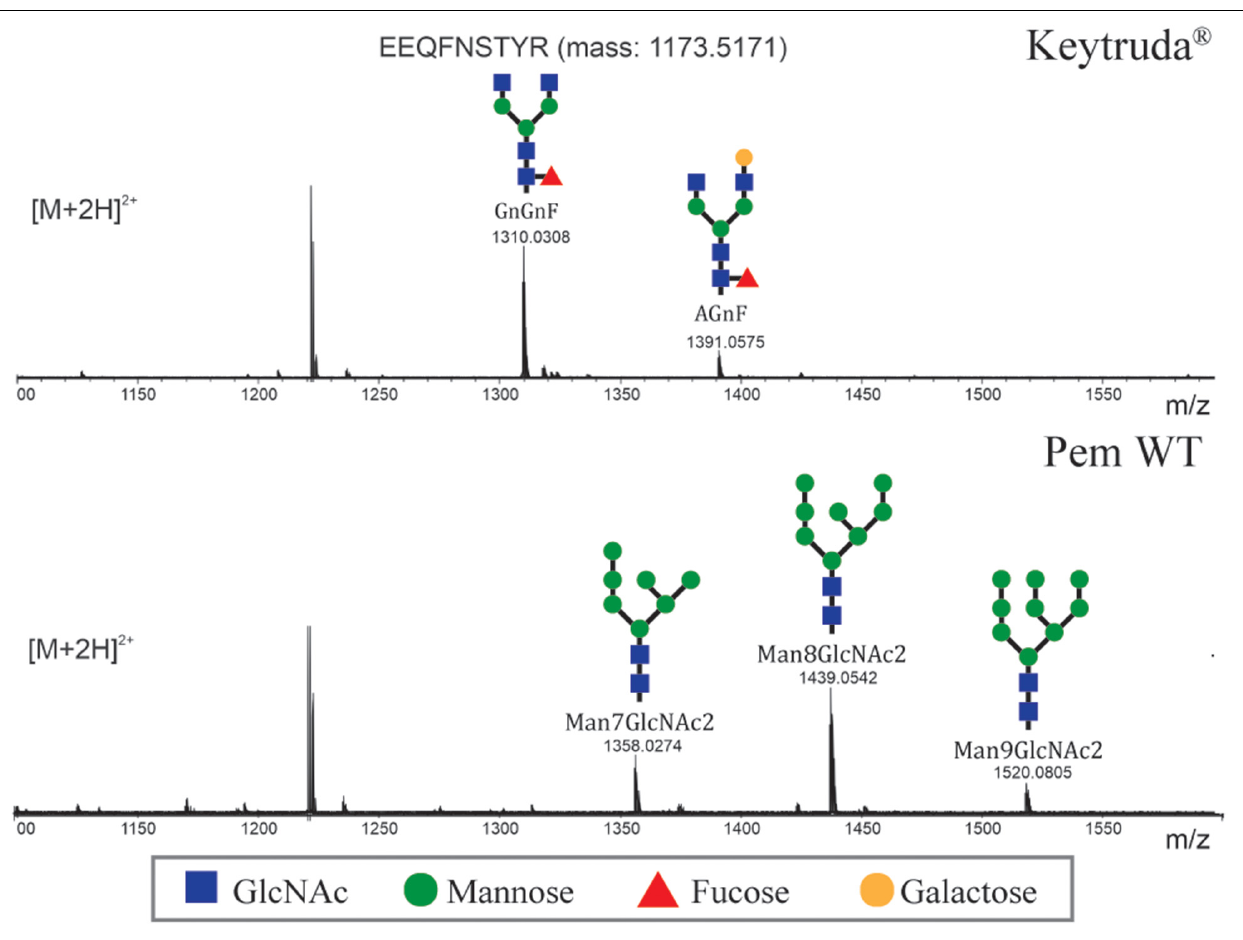
FIGURE 3 | N-glycosylation profile of plant-produced Pembrolizumab. The N-glycosylation profile of the glycopeptide EEQFNSTYR is shown, and the major glycosylated peaks [M + 2H] 2 + are depicted. For a detailed explanation of glycan structure abbreviations, see